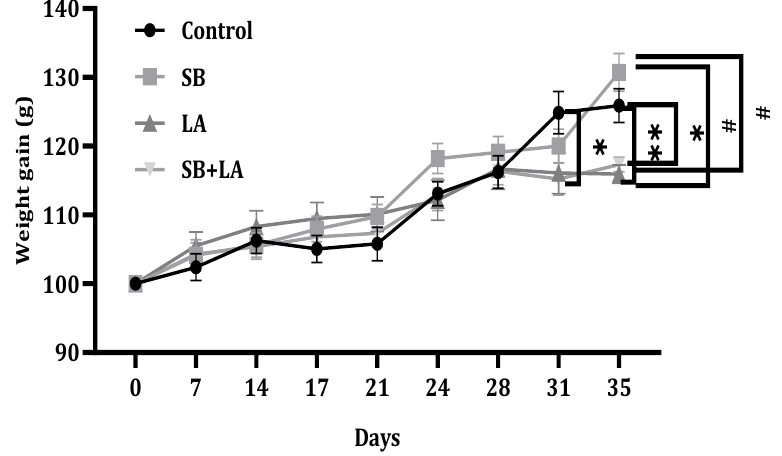
Figure 1. Effect of sodium butyrate, lead acetate, and their combination on body weight gain in adult female rats. Mean±SEM, n=10. Control, rats received only drinking water; SB, rats orally received sodium butyrate at 200 mg/kg BW; LA, rats orally received lead acetate at 50 mg/kg BW; SB+LA, rats orally received both sodium butyrate at 200 and lead acetate at 50 mg/kg BW. * P ≤0.05, ** P ≤0.01, *** P ≤0.001,